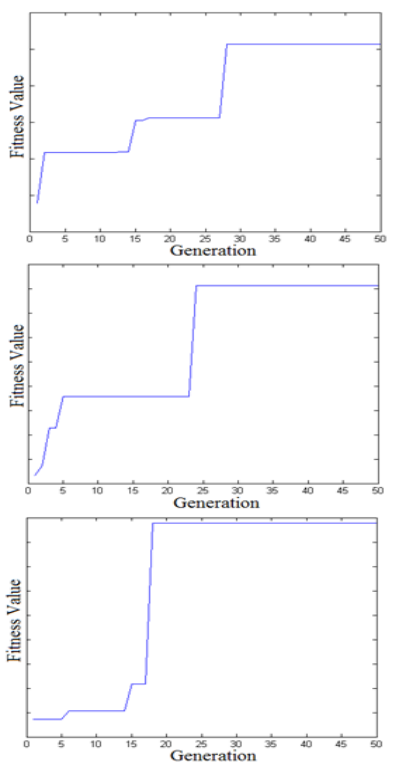
Figure 4. An example of fitness value increasing in order to different generations of GA. Table 1. Classification results using proposed method for different runs of GA method ( SZ = 1 & NC = -1 ).